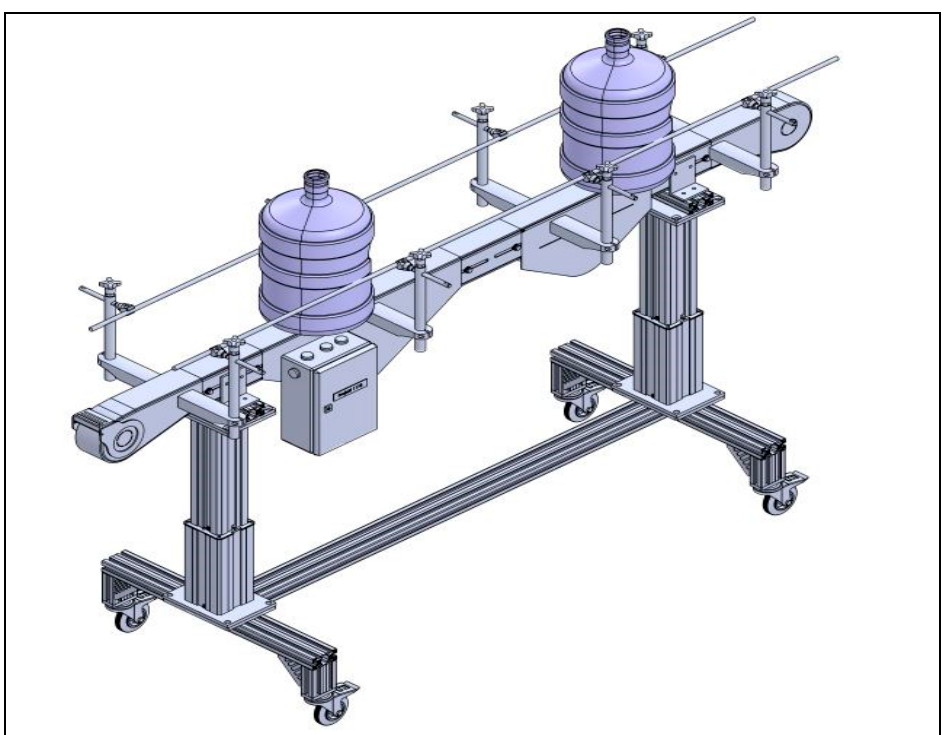
Figure 9. Concept 2—Narrow lane.